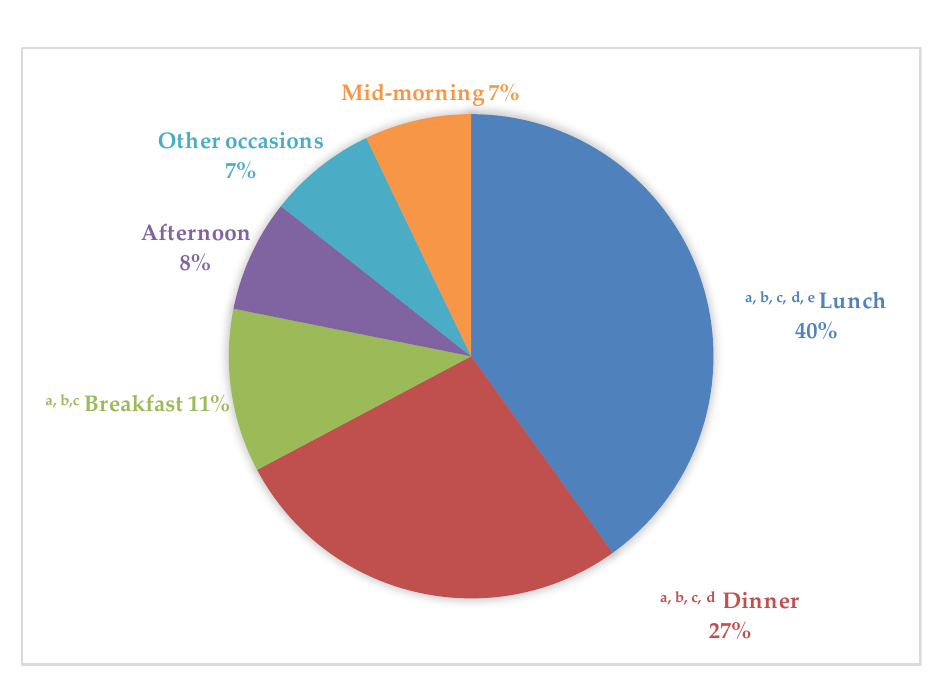
Figure 2. Percentage of household and out-of-home plate waste at different eating occasions, across the ANIBES study population. a p ≤ 0.001 mid-morning vs. breakfast, dinner, and lunch (Kruskal–Wallis and Dunn Test to adjust for multiple comparison). b p ≤ 0.001 other occasions vs. breakfast, dinner, and lunch (Kruskal–Wallis and Dunn Test to adjust for multiple comparison). c p ≤ 0.001 afternoon vs. breakfast, dinner, and lunch (Kruskal–Wallis and Dunn Test to adjust for multiple comparison). d p ≤ 0.001 breakfast vs. dinner and lunch (Kruskal–Wallis and Dunn Test to adjust for multiple comparison).